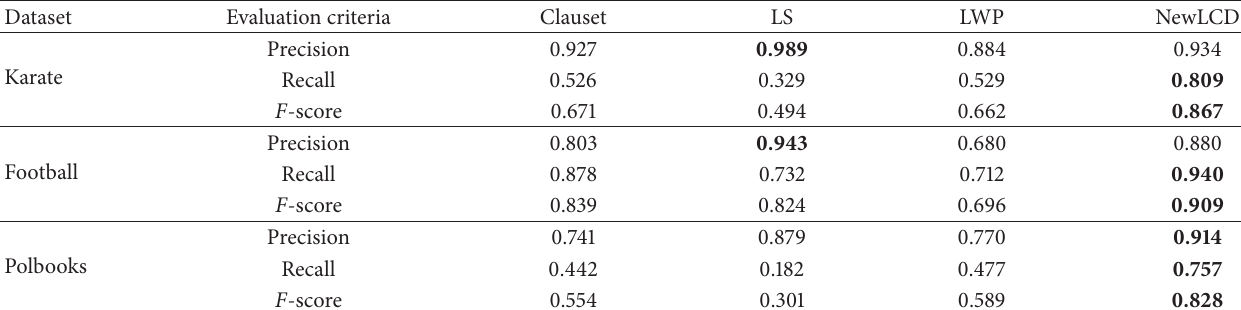
Table 3: The comparison of algorithms on the real networks.